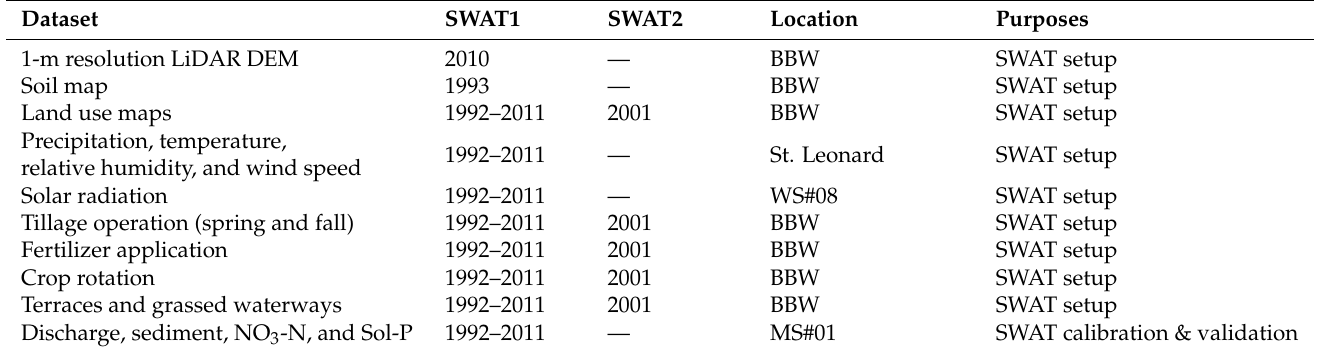
Table 1. Datasets used in model setup, calibration, and validation of SWAT1 and SWAT2.